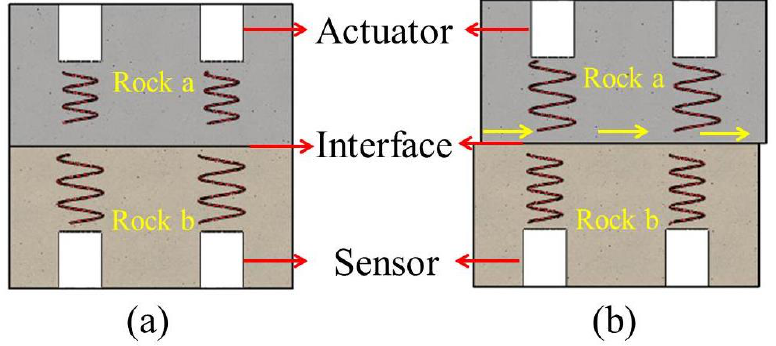
Figure 3. Schematic of active sensing method based on piezoelectric SA : ( a ) before shear failure and ( b ) after shear failure.